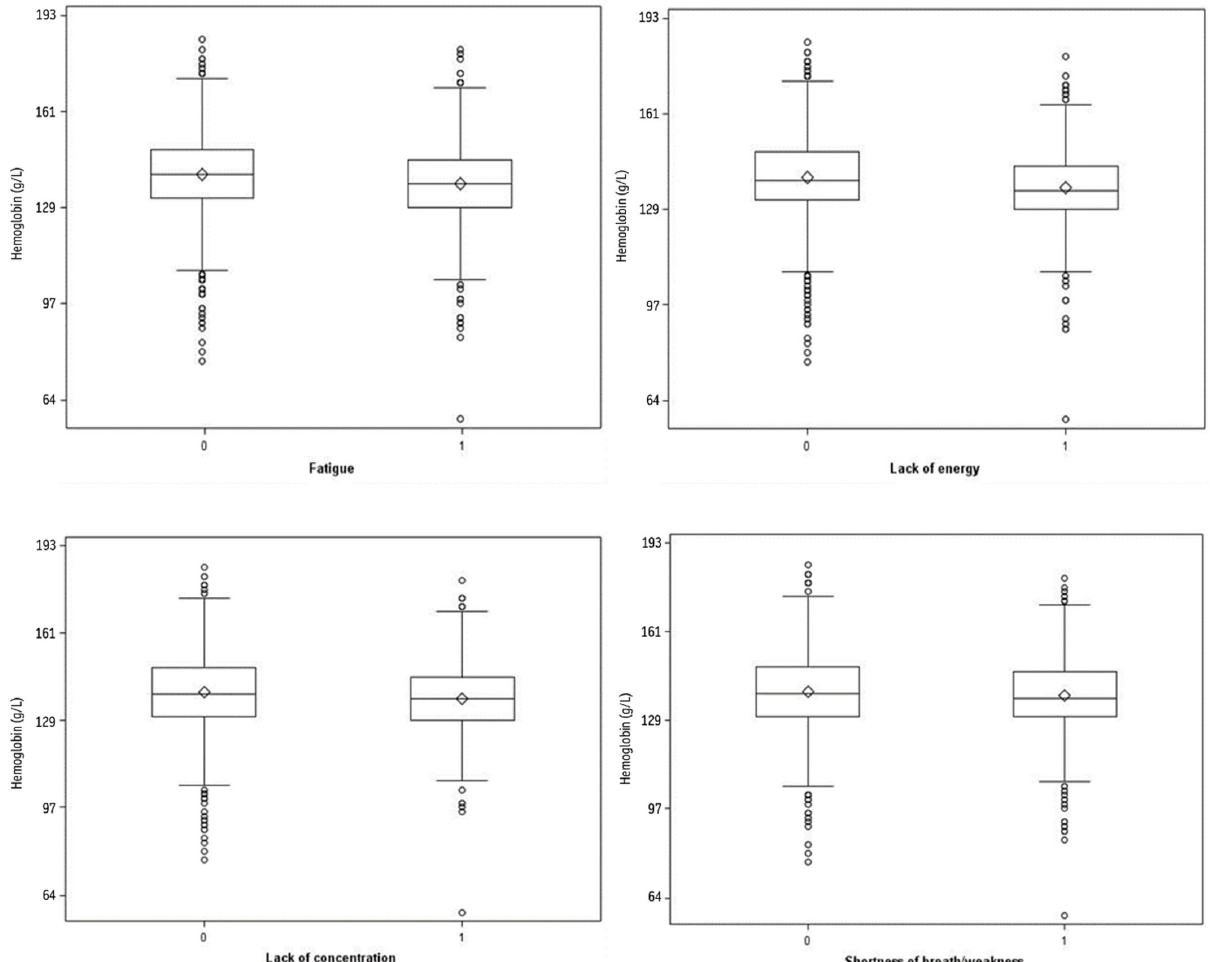
Figure 2. Box plot depiction of continuous hemoglobin levels (g/L) in study subjects according to the presence of the symptoms fatigue, lack of energy, lack of concentration, and dyspnea and weakness (0 = symptom is not present; 1 = symptom is present) . Table 5. Multivariate logistic regression models with symptoms of anemia as outcome variables (weighted).